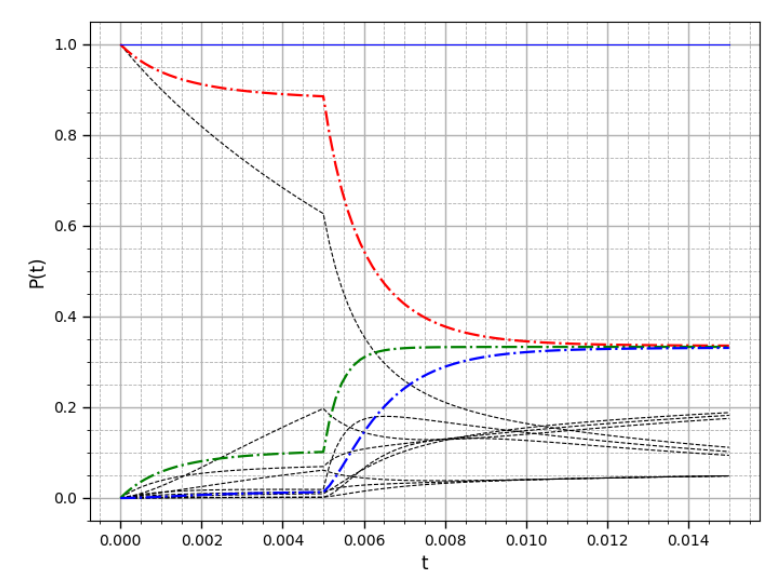
Figure 3. Dependencies of state probabilities on time in the case of an abrupt change in the arrival intensity ( λ 1 + λ < µ , λ 2 + λ ≈ µ ).